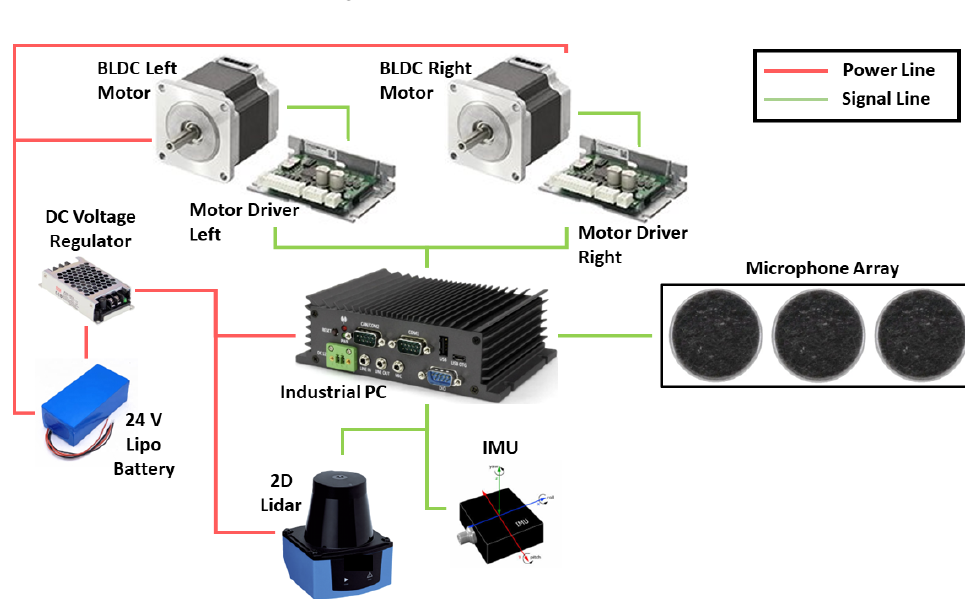
Figure 4. System Architecture of the Cleaning